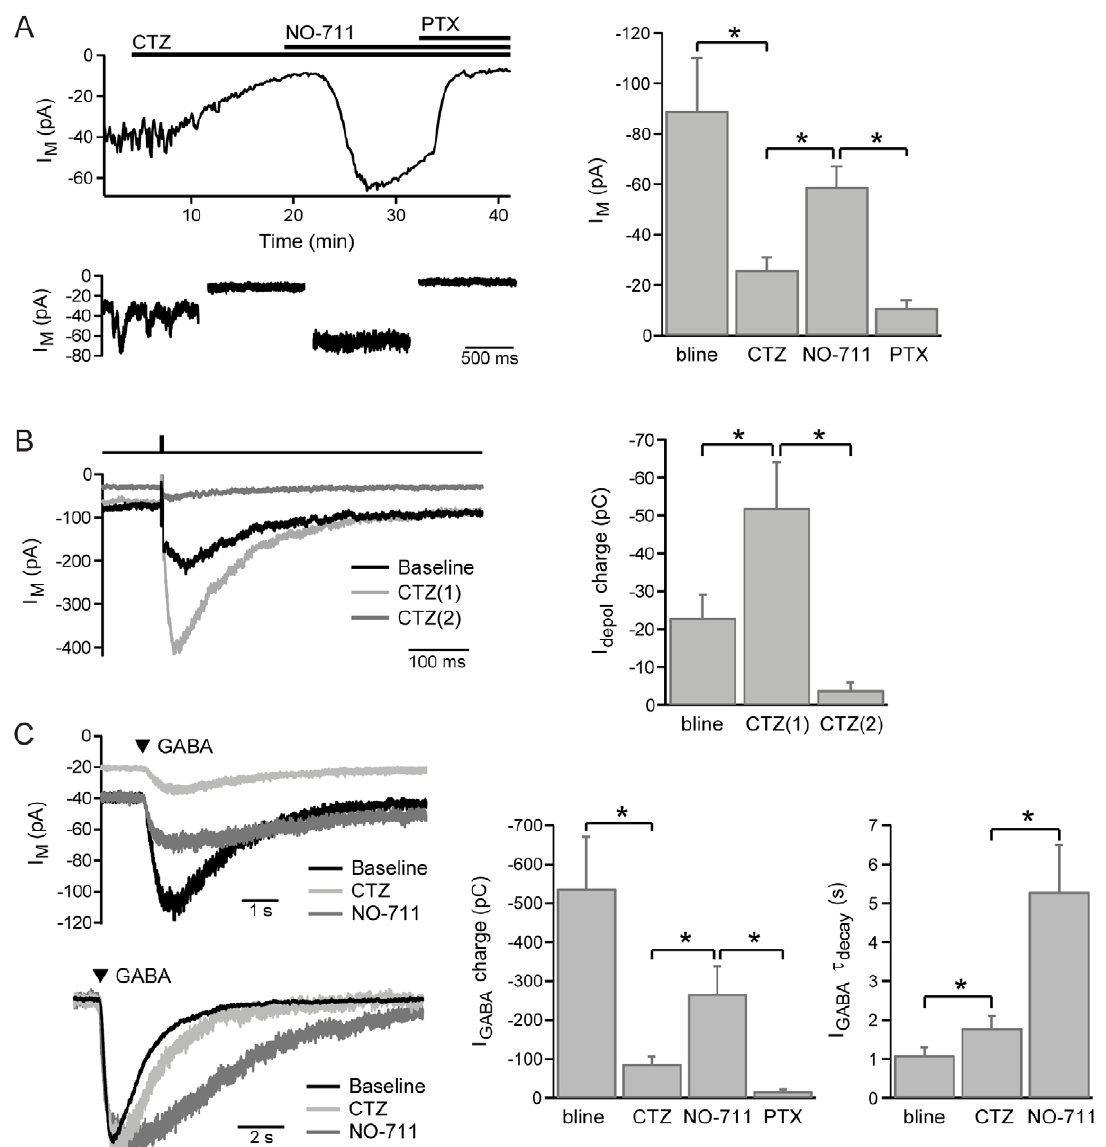
Figure 5. Cyclothiazide-sensitivity of GABA C R-currents. A, Example experiment showing the effect of cyclothiazide (CTZ; 300 m M) on the holding current, with subsequent application of NO-711 (3 m M) and picrotoxin (250 m M), with mean data for these experiments (n=10). B, Example synaptic feedback currents evoked by brief BCT depolarization (to 2 10 mV for 5 ms) during wash-on of cyclothiazide, and mean data showing the biphasic effect of cyclothiazide on the charge of feedback responses (n=8). CTZ(1) was measured 3–4 mins after application, CTZ(2) was measured 6– 8 mins after application. C, Example GABA-evoked responses (100 m M, 50–100 ms) showing the effects of cyclothiazide and NO-711 on response amplitude (top) and kinetics (bottom, peak-scaled responses from a different experiment), with mean data (n=7) for the charge and decay time- constant of GABA-evoked responses under these conditions.